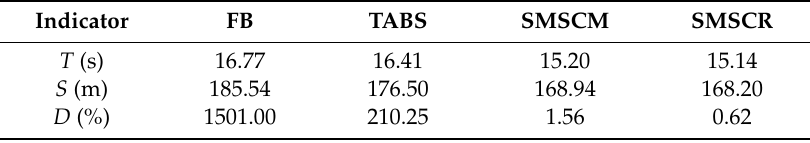
Figure 8. Simulation results of four emergency braking control strategies mentioned in Section 4.1 on ice. They are the curves of vehicle and track speed, slip ratio, and braking torque of: ( a ) FB; ( b ) TABS; ( c ) SMSCM; ( d ) SMSCR. Table 4. The value of indicators in the simulations on ice.